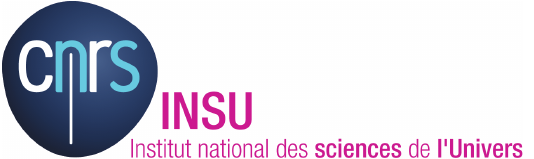
Fig. B1. Coordinated flights over Thringen on 26 May 2001 at 14:30:00h UTC (in situ: plain line, LSCE flasks: plain circles; Jena flasks: open